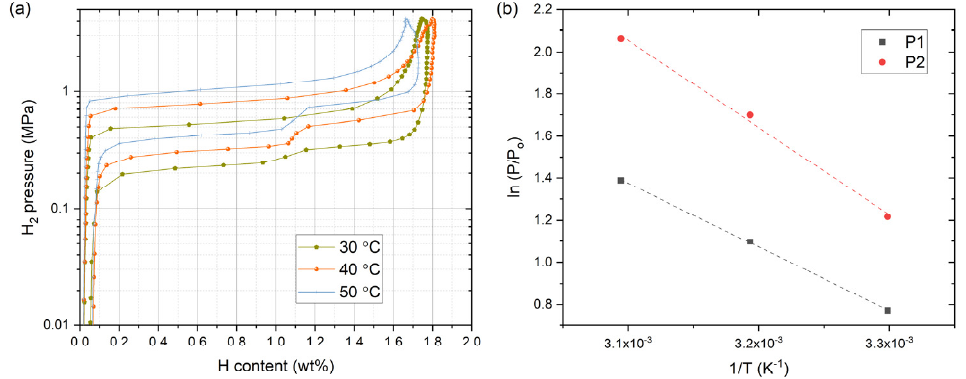
Figure 10. ( a ) PCI curves for sample 8 at 30, 40, and 50 ◦ C; ( b ) van’t Hoff plots of the desorp- tion plateau pressures for sample 8. The dashed lines in ( b ) are the linear regression results and P 0 = 1.01325 × 10 5